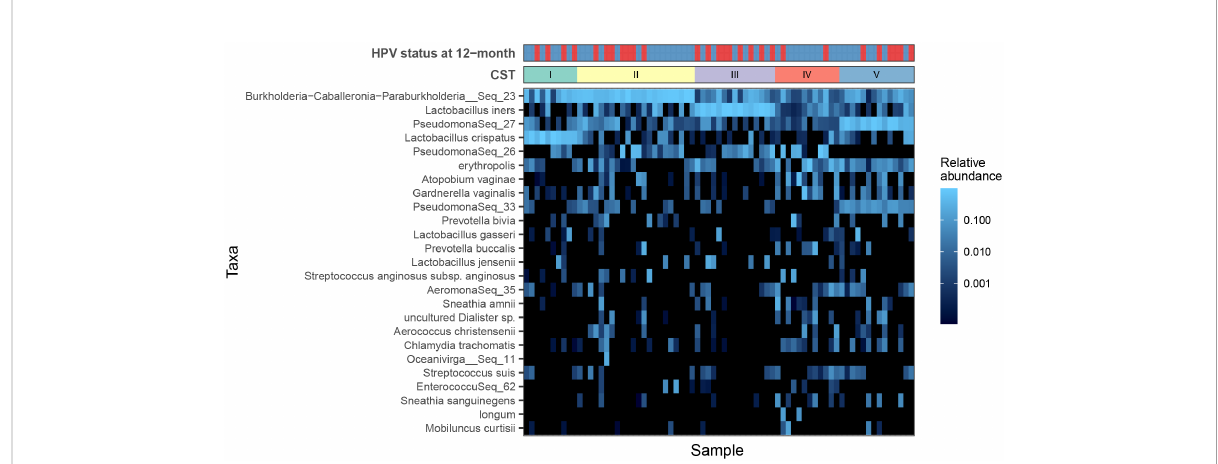
FIGURE 2 Heat map of the fractional abundance of the 25 most abundant amplicon sequence variants (ASVs) in the vaginal communities of all subjects. Clustering on the abundance pro fi les of individual samples using the partitioning around medoids algorithm identi fi es fi ve community state types. Human papillomavirus (HPV) infection outcomes are indicated by the bar at the top: HPV negative (blue) and HPV positive (red).